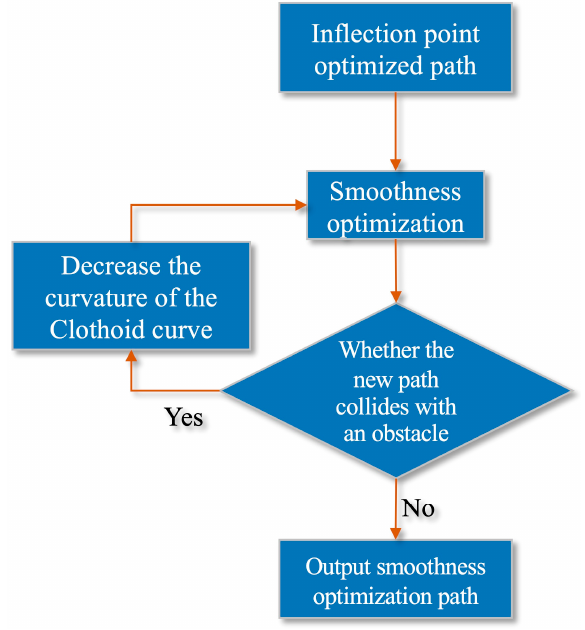
Figure 8. Smooth optimization algorithm flow chart.